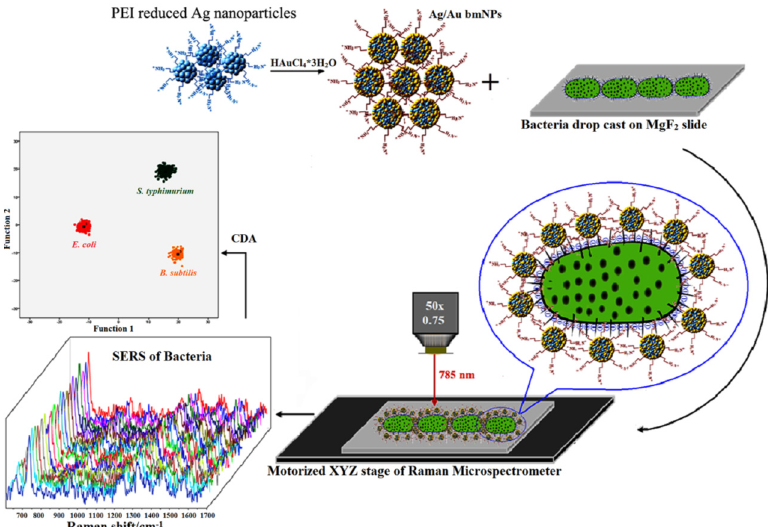
Figure 5. Scheme of a surface-enhanced Raman spectroscopy (SERS)-based sensor for bacteria detection. Republished with permission from [85]; permission conveyed through